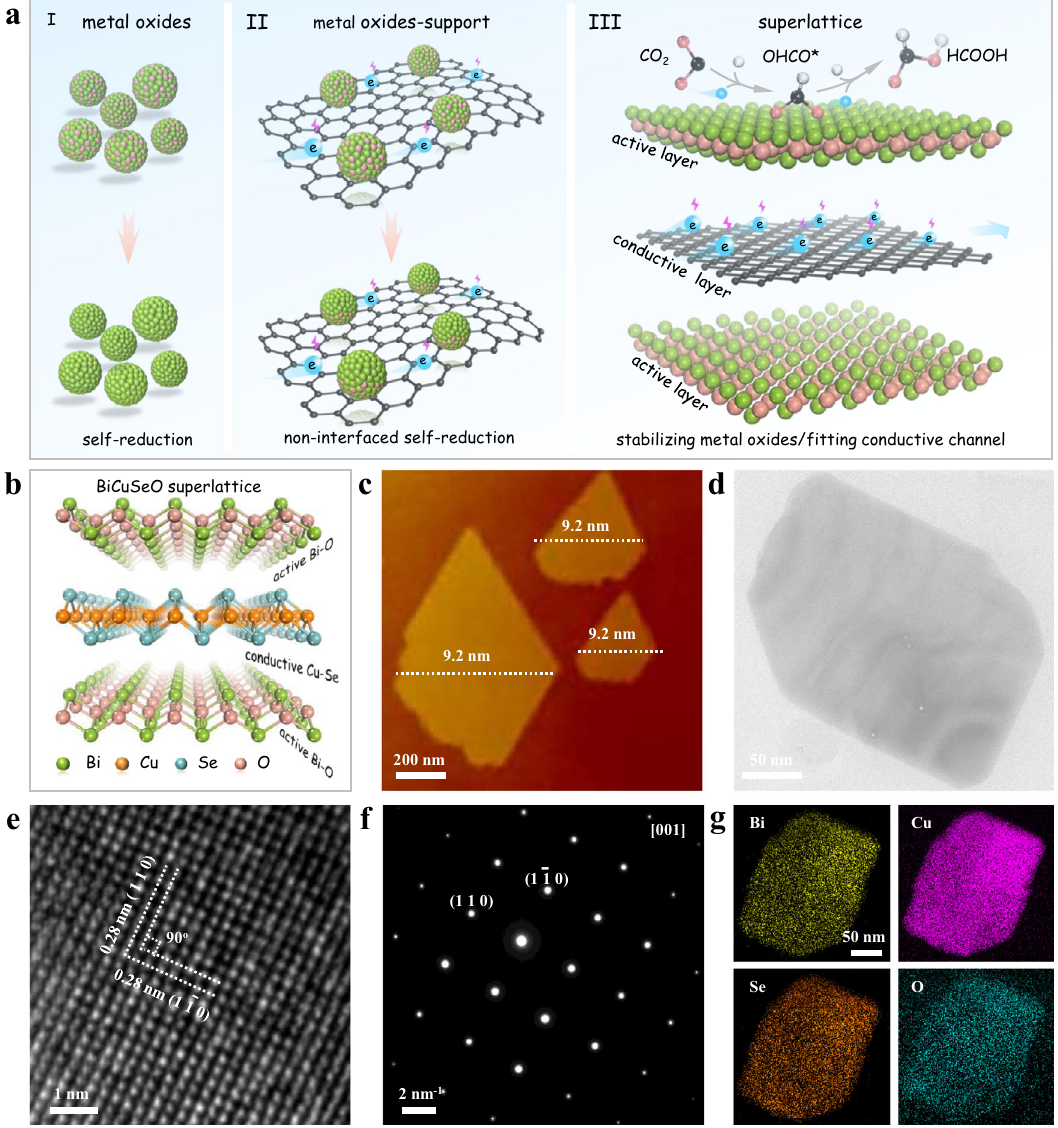
Fig. 1 Design scheme and structural characterizations of BiCuSeO superlattice nanosheets. a Schematic illustration of exploring single-phase materials with active/conductive layer alternately stacked superlattices. (I) Pure metal oxides. (II) Metal oxides – support interaction system. (III) Superlattice consisting of a one-by-one vertically stacked active layer (metal oxides) and conductive layer subunit. b Structural model of BiCuSeO superlattice. c AFM image. d TEM image. e HRTEM image. f Corresponding SAED pattern. g EDS mapping